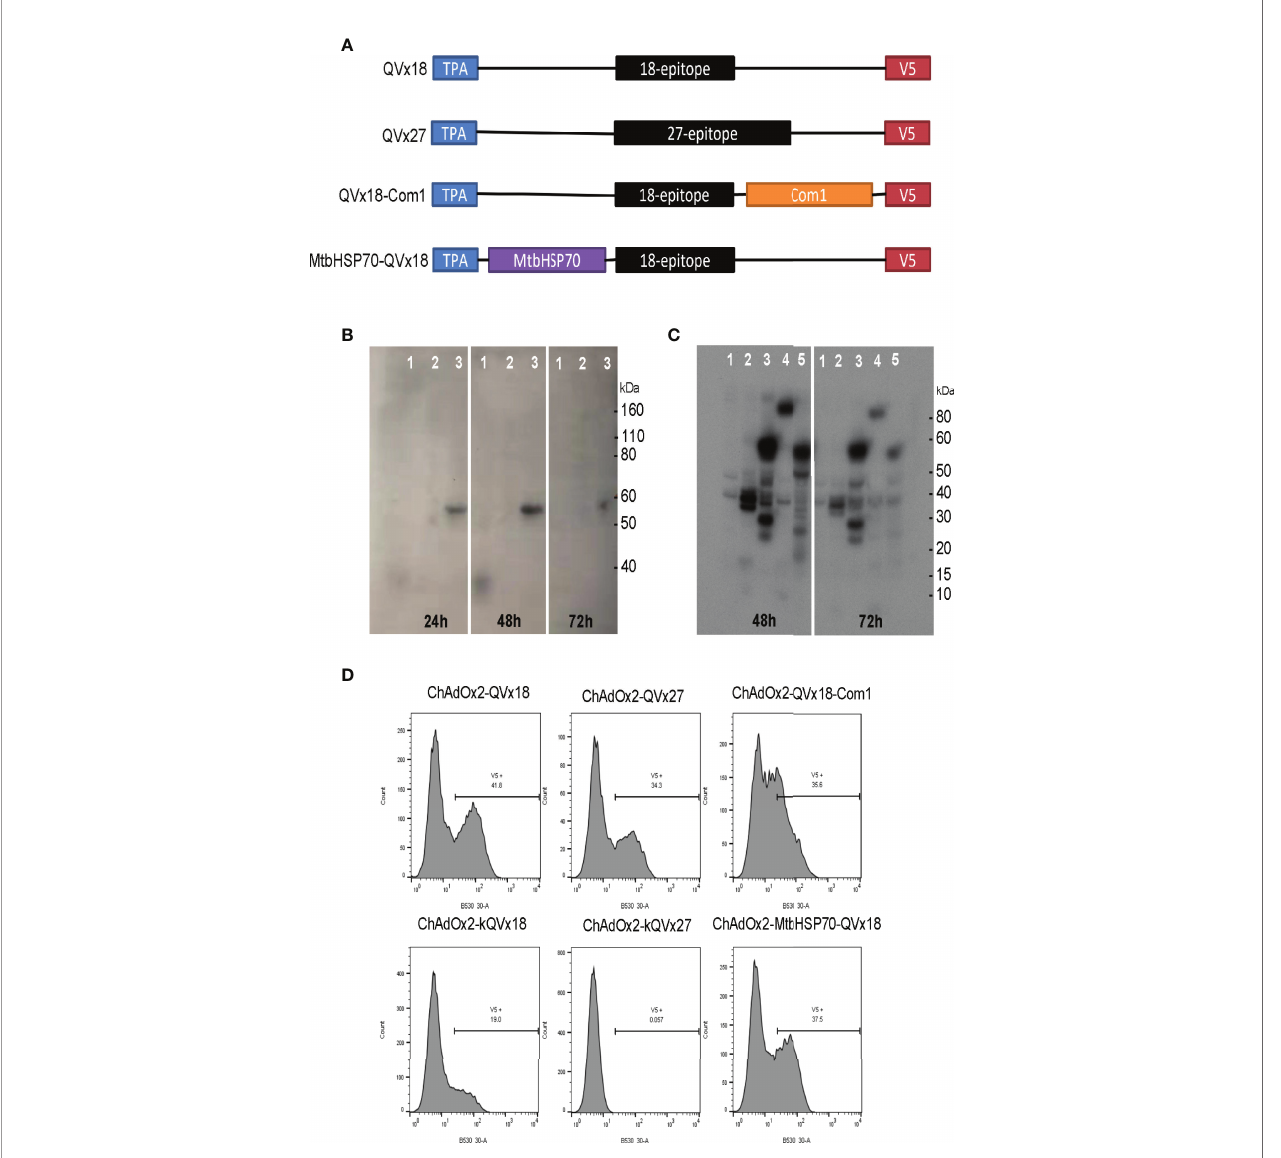
FIGURE 2 | Design and expression of multi-epitope vaccine antigens. (A) Vaccine antigen designs. Sequences of 18-epitope and 27-epitope concatemers are given in Table 5 . (B, C) Western blot analysis of epitope concatemer expression in HEK293 cells transfected with plasmids encoding the vaccine antigen inserts. Expected molecular weights: QVx18 concatemer, 36 kDa; QVx27 concatemer; 54 kDa; QVx18-Com1, 59 kDa; MtbHSP70-QVx18, 102 kDa. Vaccine antigen designs evaluated in (B) 1: QVx18; 2: empty plasmid; 3: QVx27. Vaccine antigen designs evaluated in (C) 1: empty plasmid; 2: kQVx18; 3: QVx18-Com1; 4: MtbHSP70- QVx18; 5: kQVx27. (D) Expression of vaccine antigens in HeLa cells infected with ChAdOx2 vaccine constructs detected by anti-V5 fl ow